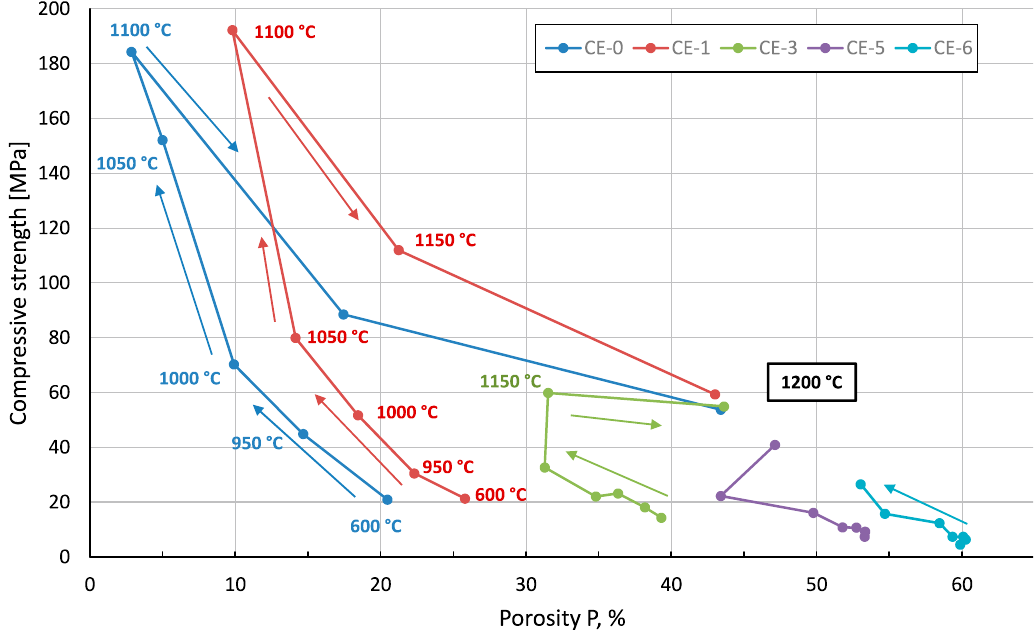
Figure 9. Dependency of compressive strength on porosity and firing temperature for material variants containing 0, 10, 30, 50 and 60 vol % of cenospheres. Arrows are meant to highlight the course of firing temperature increase for each curve.